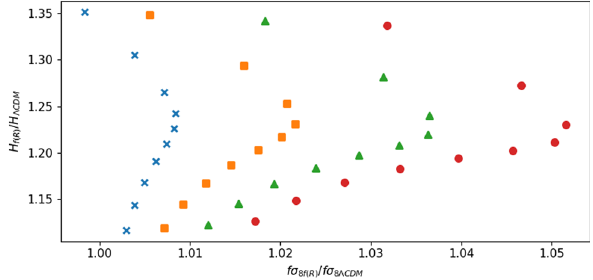
Fig. 10 Curves on the [ f σ 8 ] / [ f σ 8 ] Λ CDM × H / H Λ CDM plane for different values of the λ parameter, for the n = 1 case. The curves, while having a similar profile, have different curvatures while also having different start and end points. From left to right we have λ − 1 = 0 . 3 , 0 . 5 , 0 . 7 , 1